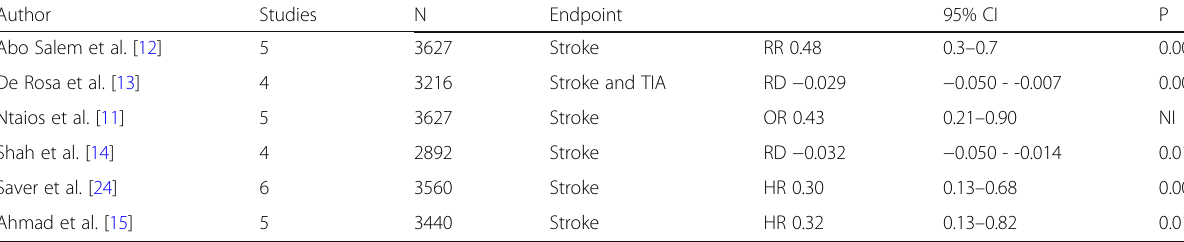
Table 3 Results of meta-analyses for PFO closure in cryptogenic stroke